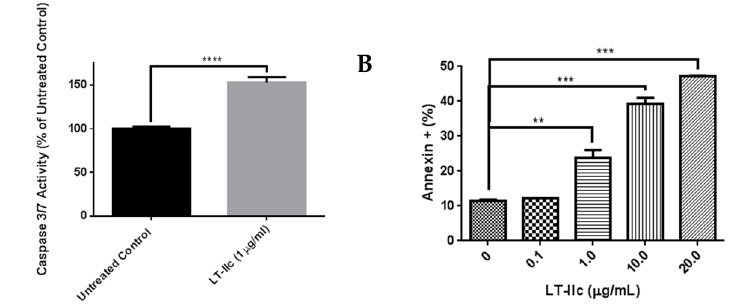
Figure 8. LT-IIc induces apoptotic cell death in TNBC cells. ( A ) MDA-MB-231 cells were treated with LT-IIc (1 µg/mL) prior to assessment of caspase 3/7 activity using a fluorescent substrate. Representative of >3 replicates from 3 independent experiments. ( B ) MDA-MB-231 cells were treated with 0, 0.1, 1.0, 10, or 20 µg/mL of LT-IIc for 24 h. Annexin V-stained cells were interrogated by flow cytometry within 1 h of staining. Bars represent means ± SEM. Key: ** p < 0.01; *** p < 0.001; **** p < 0.0001.